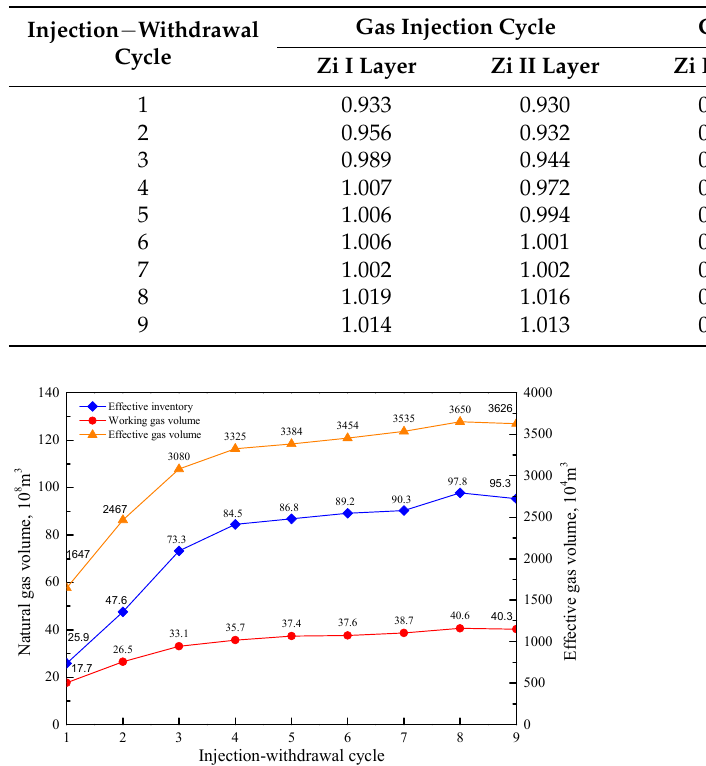
Table 2. The deviation factor calculation results for Hutubi UGS during nine injection − with- drawal cycles.